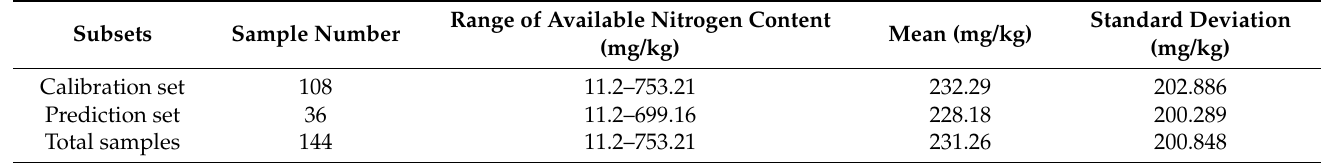
Table 1. Available nitrogen content distribution of vermiculite matrix samples.